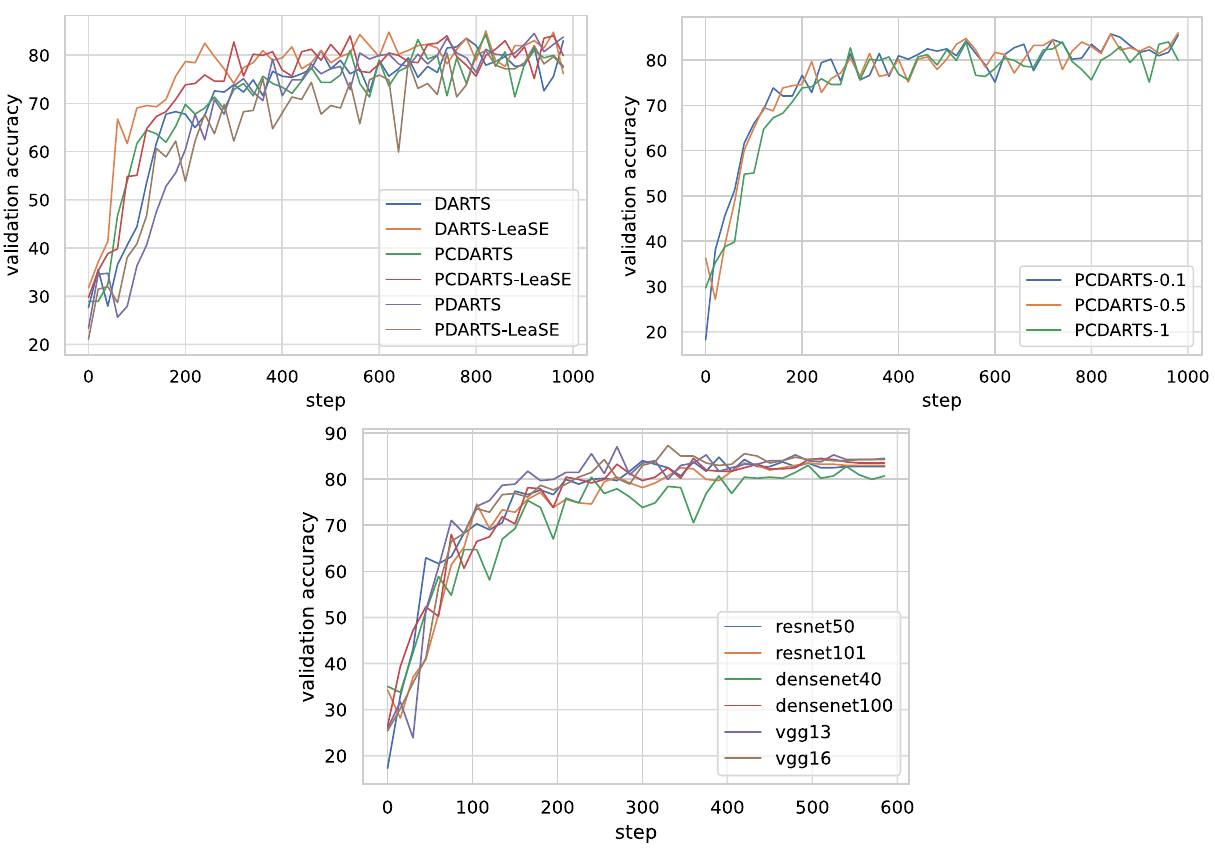
Figure 2. (Top left) Convergence curves of validation accuracy for different NAS methods with and without LeaSE. (Top right) Convergence curves of validation accuracy for LeaSE+PCDARTS under different γ values. (Bottom) Convergence curves of validation accuracy for non-NAS